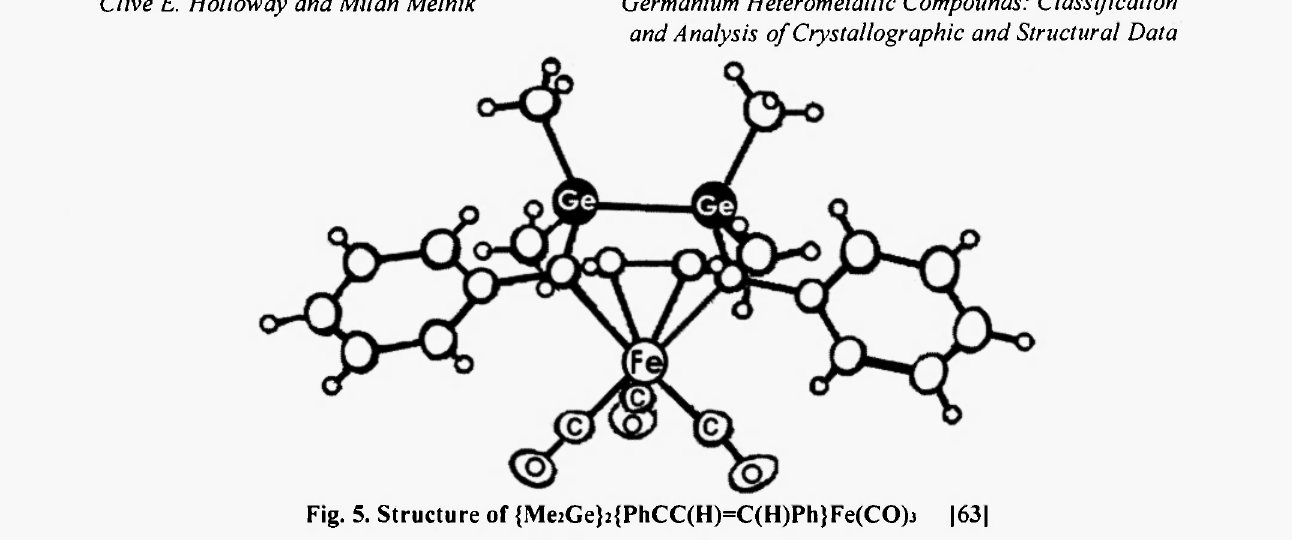
Fig. 5. Structure of {Me2Ge}:{PhCC(H)=C(H)Ph}Fe(CO)3 |63|